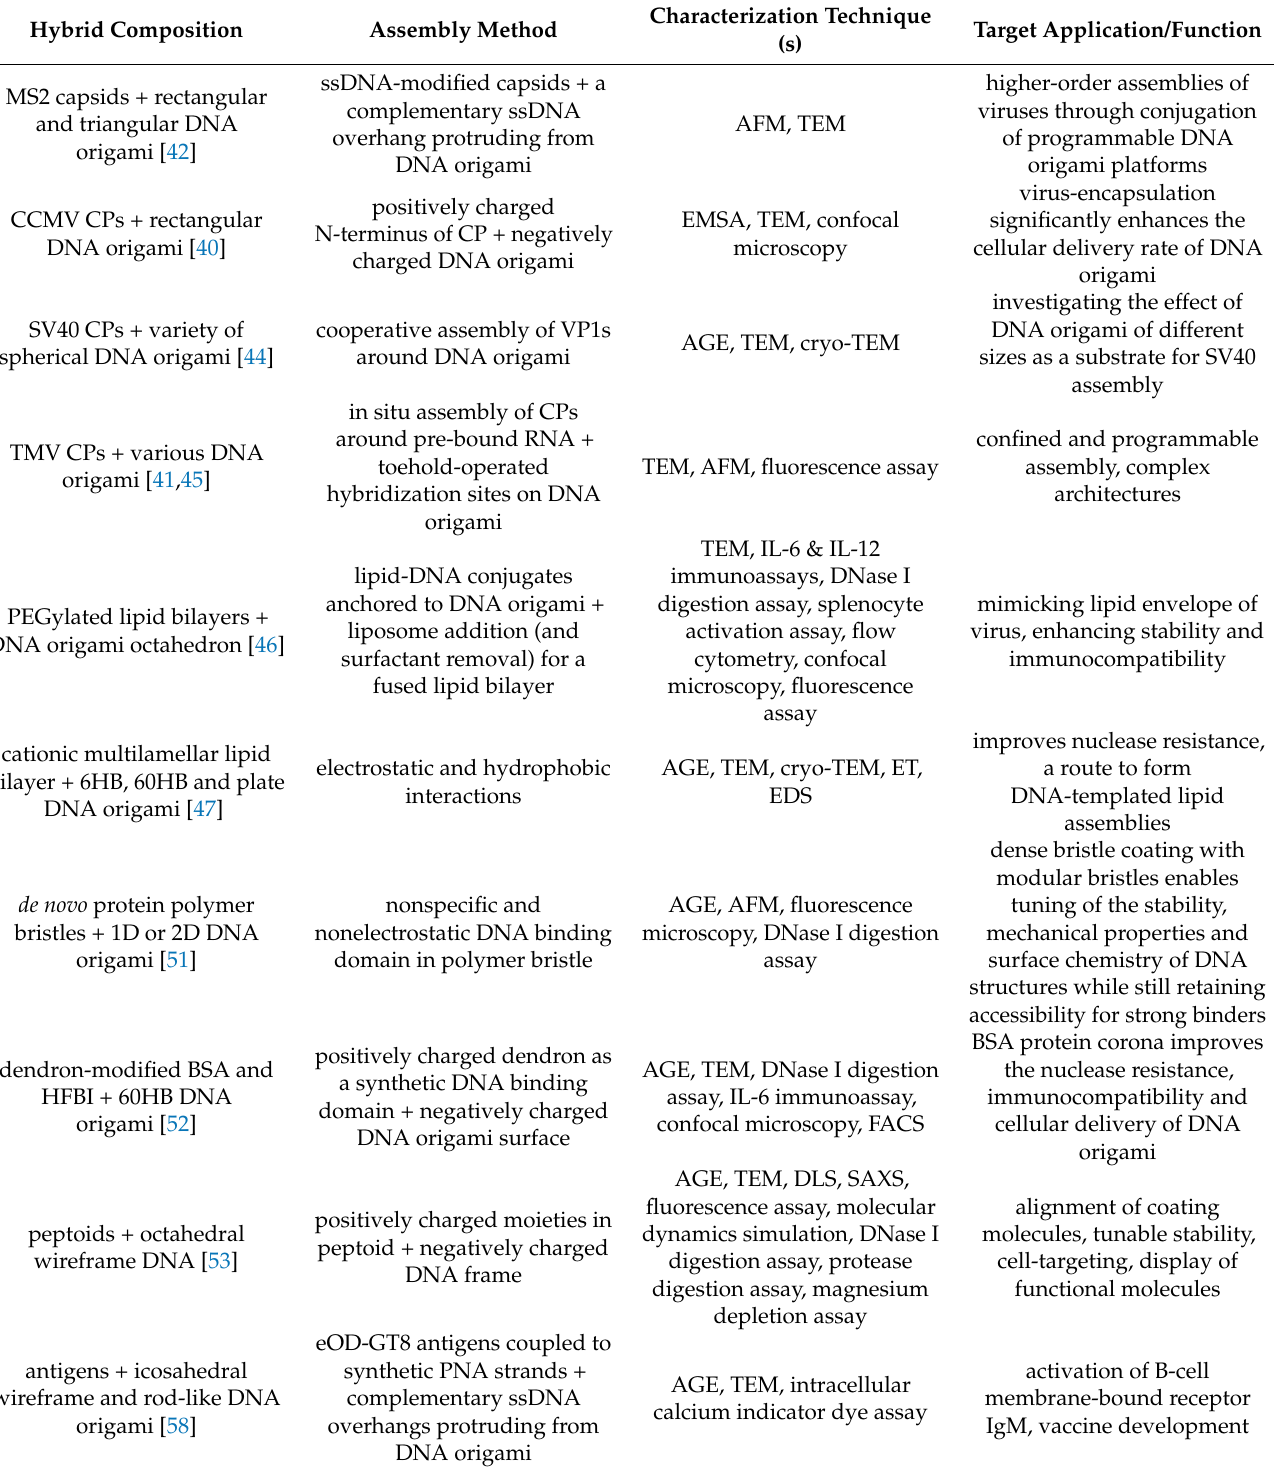
Table 1. Selected virus and virus-mimicking protein-DNA nanostructure hybrids, their assembly methods, characterization techniques and possible target